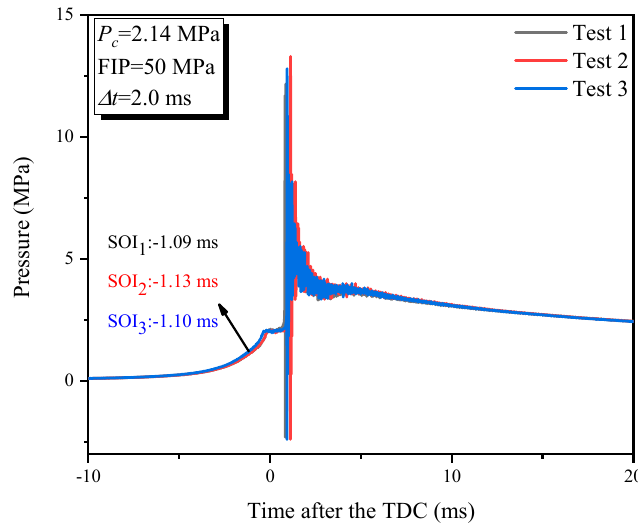
Figure 5. The capability of RCMs in studying diesel knock.